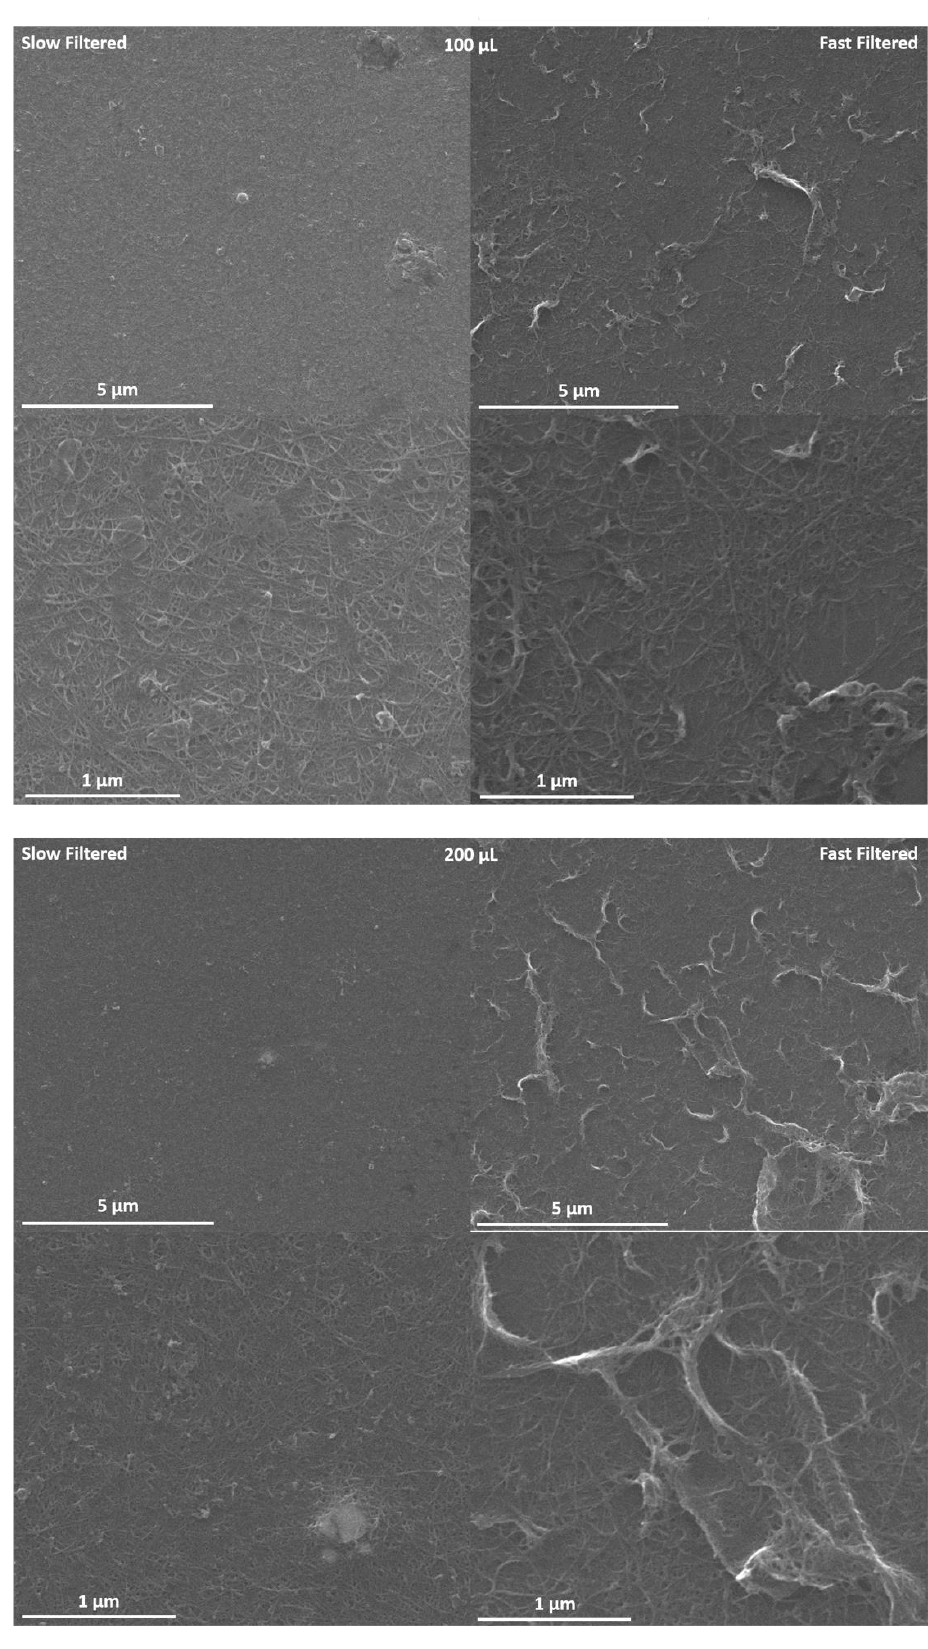
Figure 3. SEM images of arc-discharge SWCNTs filtered quickly and slowly at different volumes.